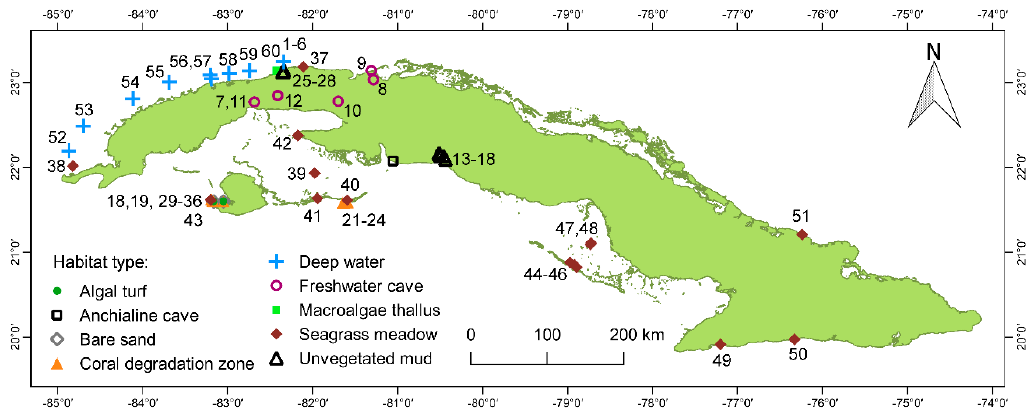
Figure 1. Map indicating the 60 sampling sites of aquatic nematode assemblages around the Cuban archipelago. Symbols indicate the nine habitat types.